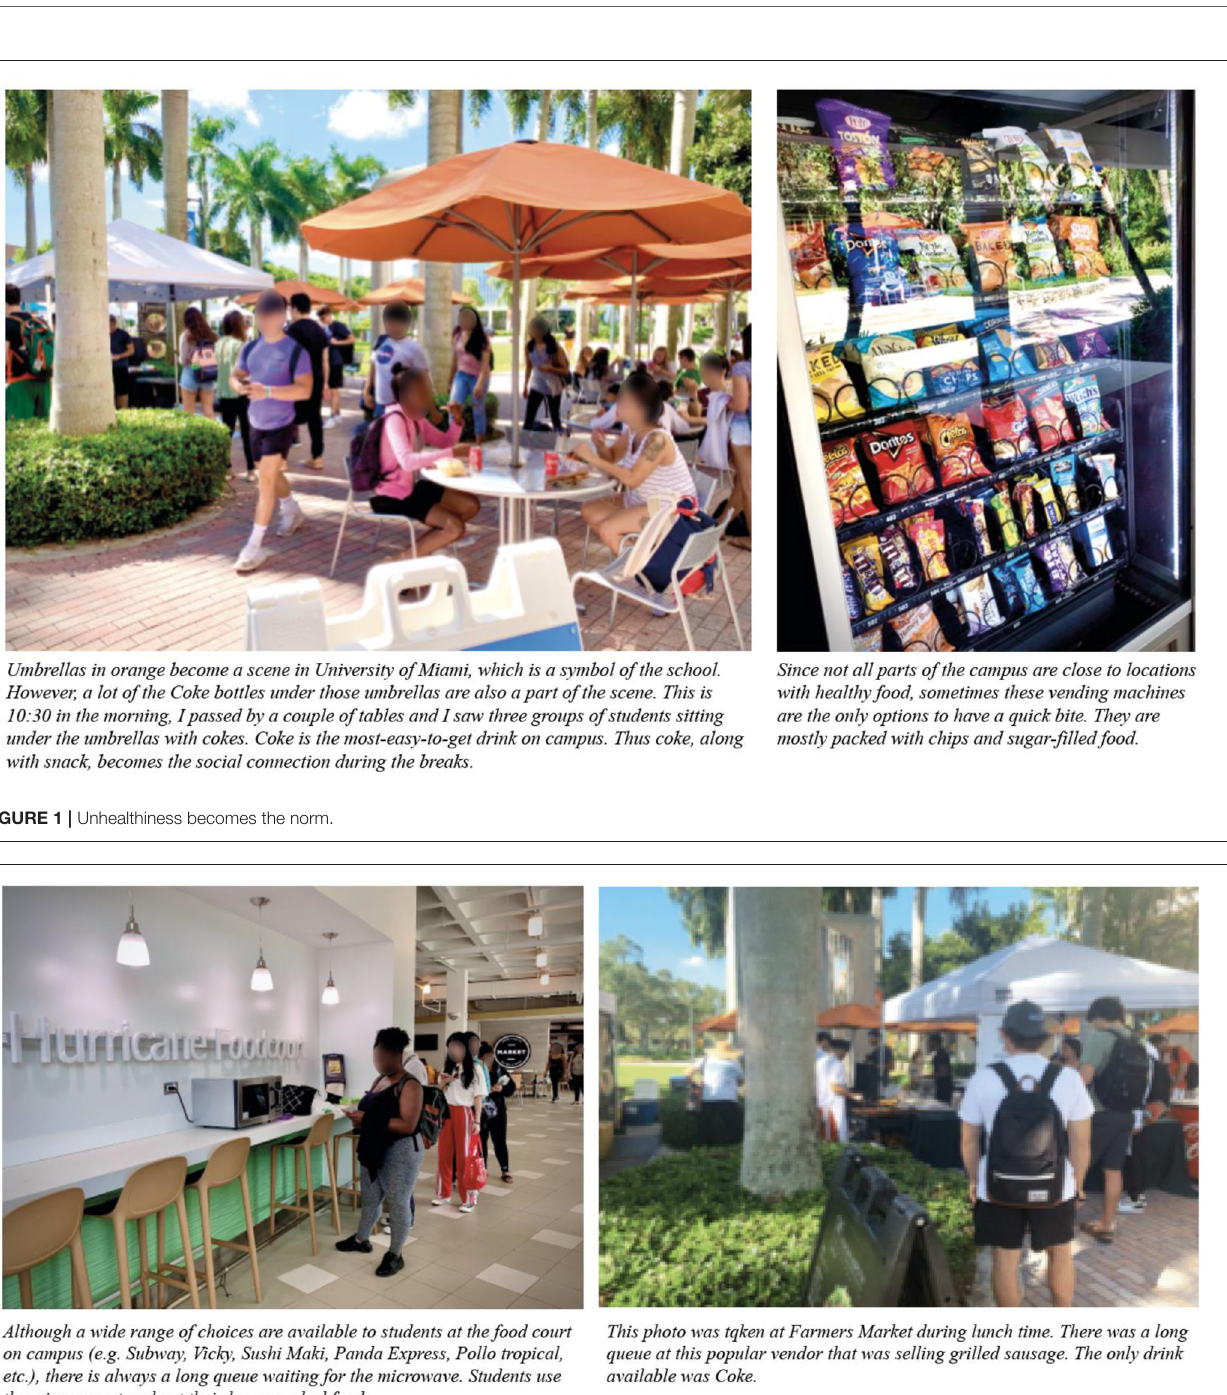
FIGURE 2 | Convenience of